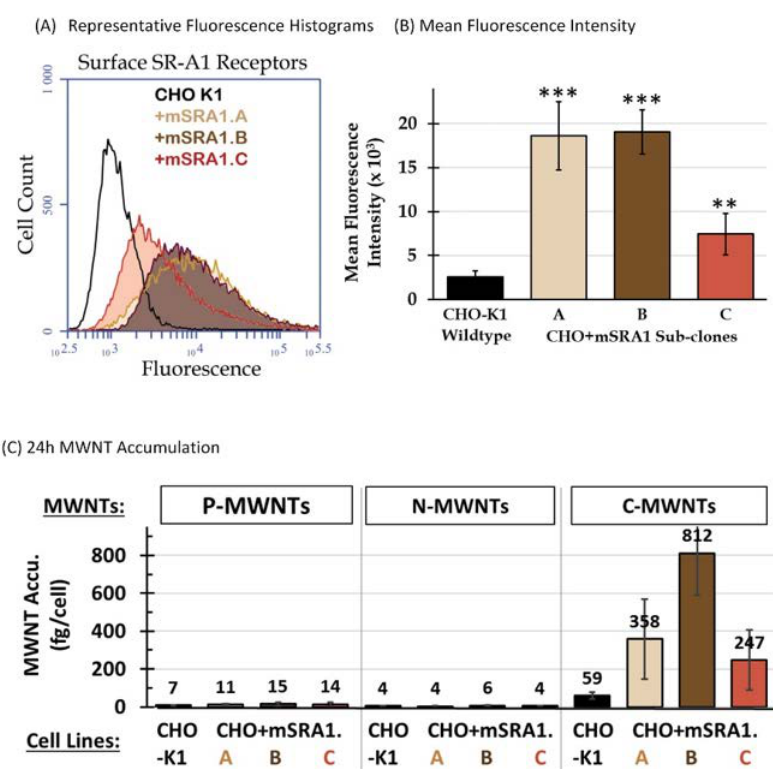
Figure 2. Surface SR-A1 receptor expression correlates with C-MWNT uptake by CHO-K1 and transfected CHO + mSRA1 clones. ( A , B ) Cell surface expression of SR-A1 receptors was determined by direct immunofluorescence FCyt assays. Cells detached from the culture vessel with enzyme-free bu ff er were incubated with mouse IgG to block Fc receptors before incubation with Alexa Fluor ® 488-conjugated monoclonal anti-mouse mSR-A1 antibody. Alexa Fluor ® 488-conjugated rat IgG2b was used as isotype control. Cells with fluorescence intensity greater than the background isotype control were considered positive. The mean fluorescence intensity represents the surface expression level of SR-A1 receptors by the 20,000 cells analyzed. ( A ) Representative fluorescence histograms of cells stained with anti-mSR-A1. Black, untransfected CHO-K1 cells; beige, brown, and red, transfected CHO + mSRA1 sub-clones A, B, and C, respectively. ( B ) The surface SR-A1 receptor expression level represented as the mean fluorescence intensity of 20,000 cells analyzed per sample. Data are the mean ± SD of triplicate measurements of each sample in ≥ 3 independent experiments. ** is for p < 0.0005 and *** is for p < 0.00005, compared to CHO-K1. ( C ) The accumulation of P-, N-, or C-MWNTs by untransfected CHO-K1 cells and transfected CHO + mSRA1 sub-clones A, B, and C was determined after exposing cells to media containing 100 µ g / mL of P-, N-, or C-MWNT for 24 h at 37 ◦ C. After incubation, the cells were washed, cell counts were determined using a Coulter Particle Counter, and MWNTs were extracted and quantified using the SDS-PAGE method. Numbers above the bars are the average fg MWNTs per cell. Data are the average ± SD of ≥ 3 independent